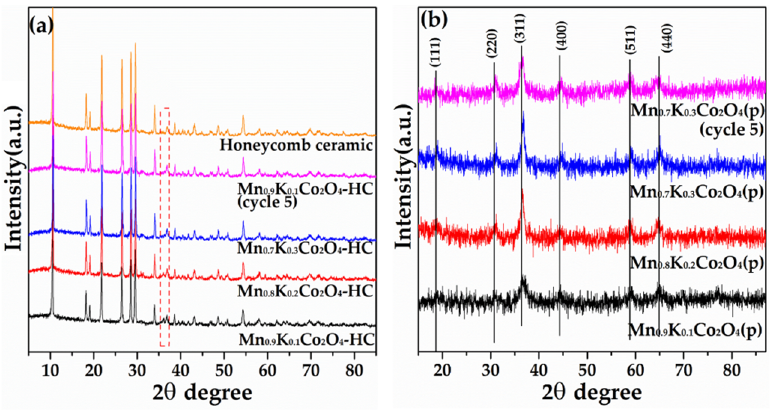
Figure 6. XRD of Mn 1 − n K n Co 2 O 4 -HC monolith catalysts ( a ) and the corresponding powder catalysts ( b ).